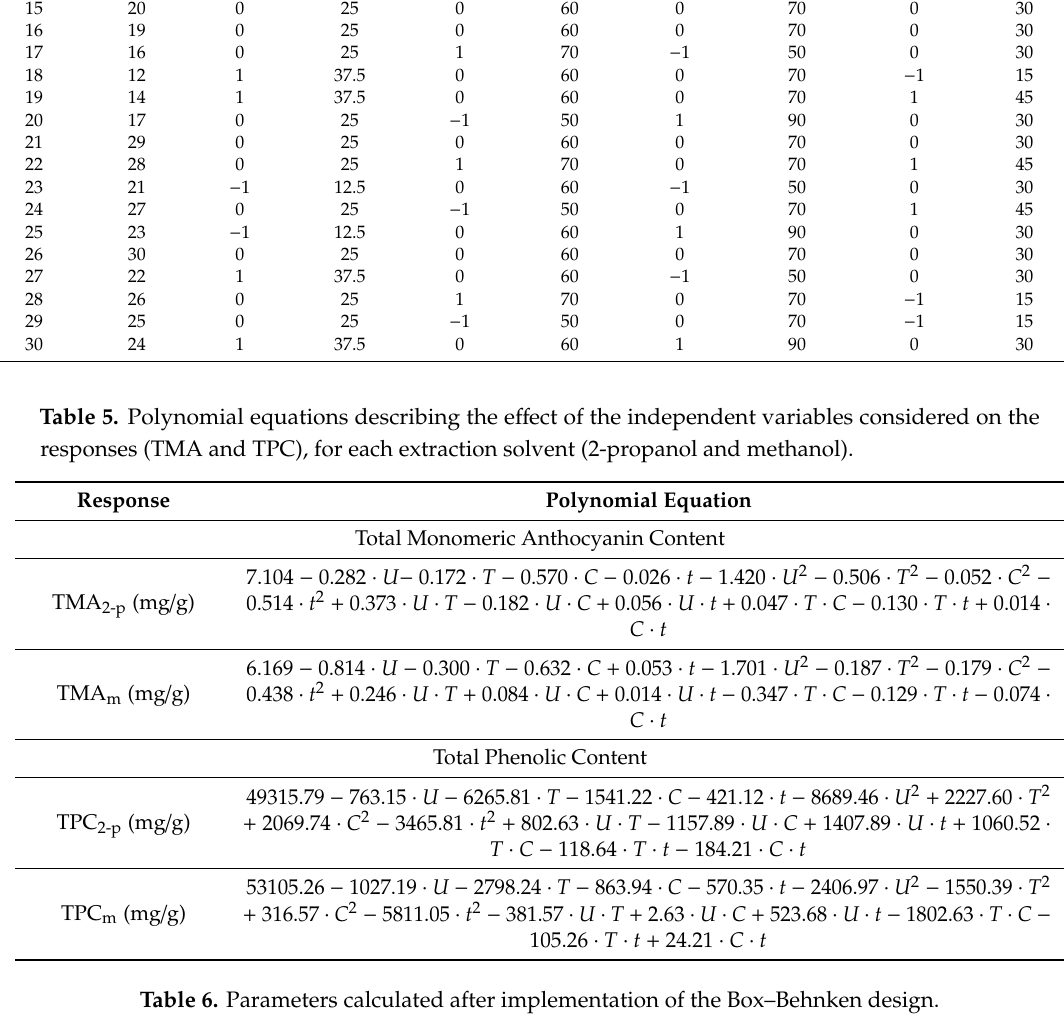
Table 6. Parameters calculated after implementation of the Box–Behnken design. Response Sum of Squares Mean Square F-Value R 2 Lack of